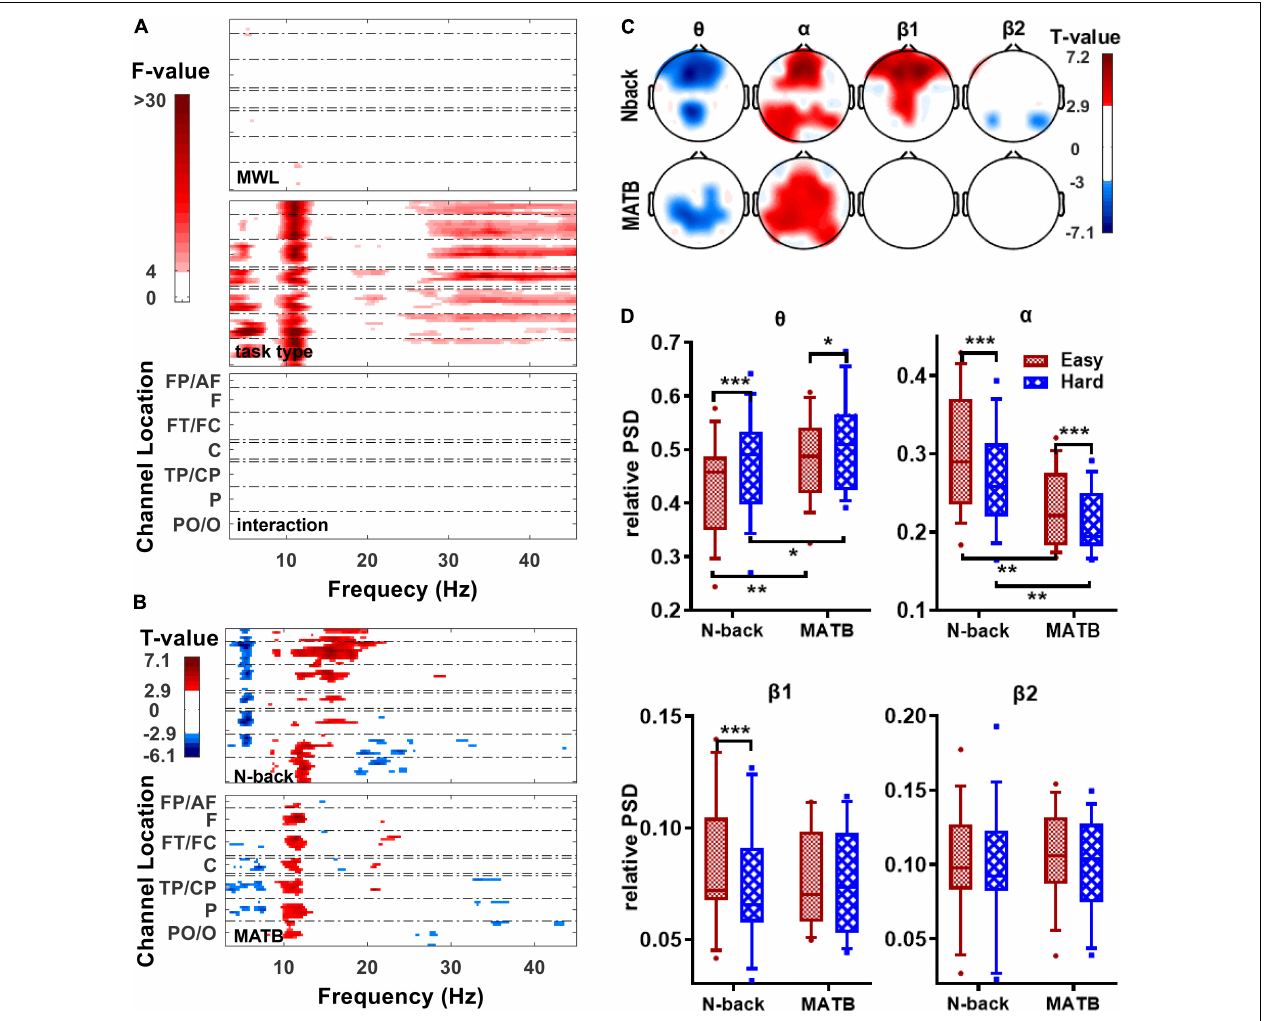
FIGURE 4 | Statistical results for the relative power spectral densities (PSDs). (A) The spatial–frequency maps of F -values obtained from two-way (MWL × task type) repeated-measure ANOVAs on the relative PSDs at each channel and each frequency. (B) The spatial–frequency maps of T -values obtained from paired t -tests (easy–hard) on relative PSDs at each channel and each frequency in N-back (upper panel) and MATB (bottom panel). (C) The topological maps of T -values obtained from paired t -tests (easy–hard) on the relative powers of the four bands at each channel in N-back (upper panel) and MATB (bottom panel). (D) The box plots of the relative PSDs of the four bands at Fz. The asterisks in the figure indicate the significance level of the statistical analyses: * p FDR < 0.05; ** p FDR < 0.01; *** p FDR < 0.001. The statistics of no significance ( p FDR > 0.05) were set to 0 in (A–C) . AF, anteriofrontal; FP, pre-frontal; F, frontal; FT, frontotemporal; FC, frontocentral; C, central; CP, centroparietal; TP, temporoparietal; PO, parietooccipital; O,